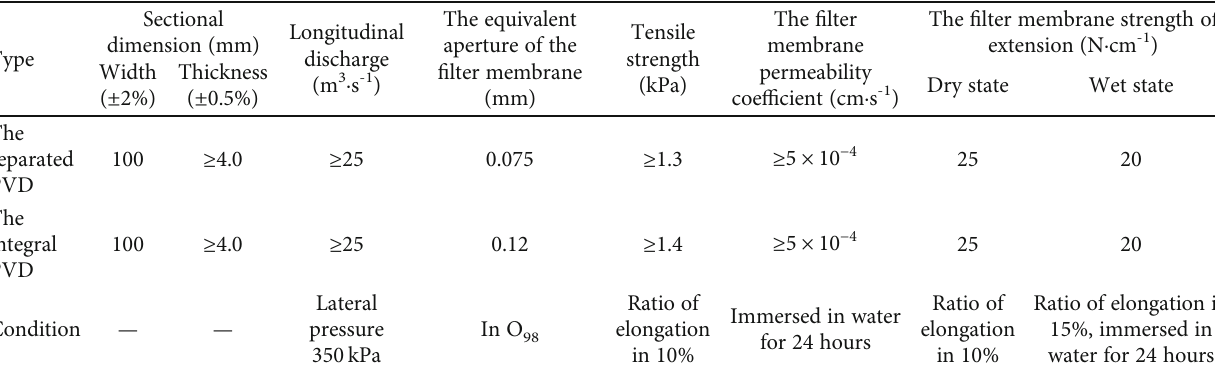
Table 3: Performance index of two kinds of drainage board.